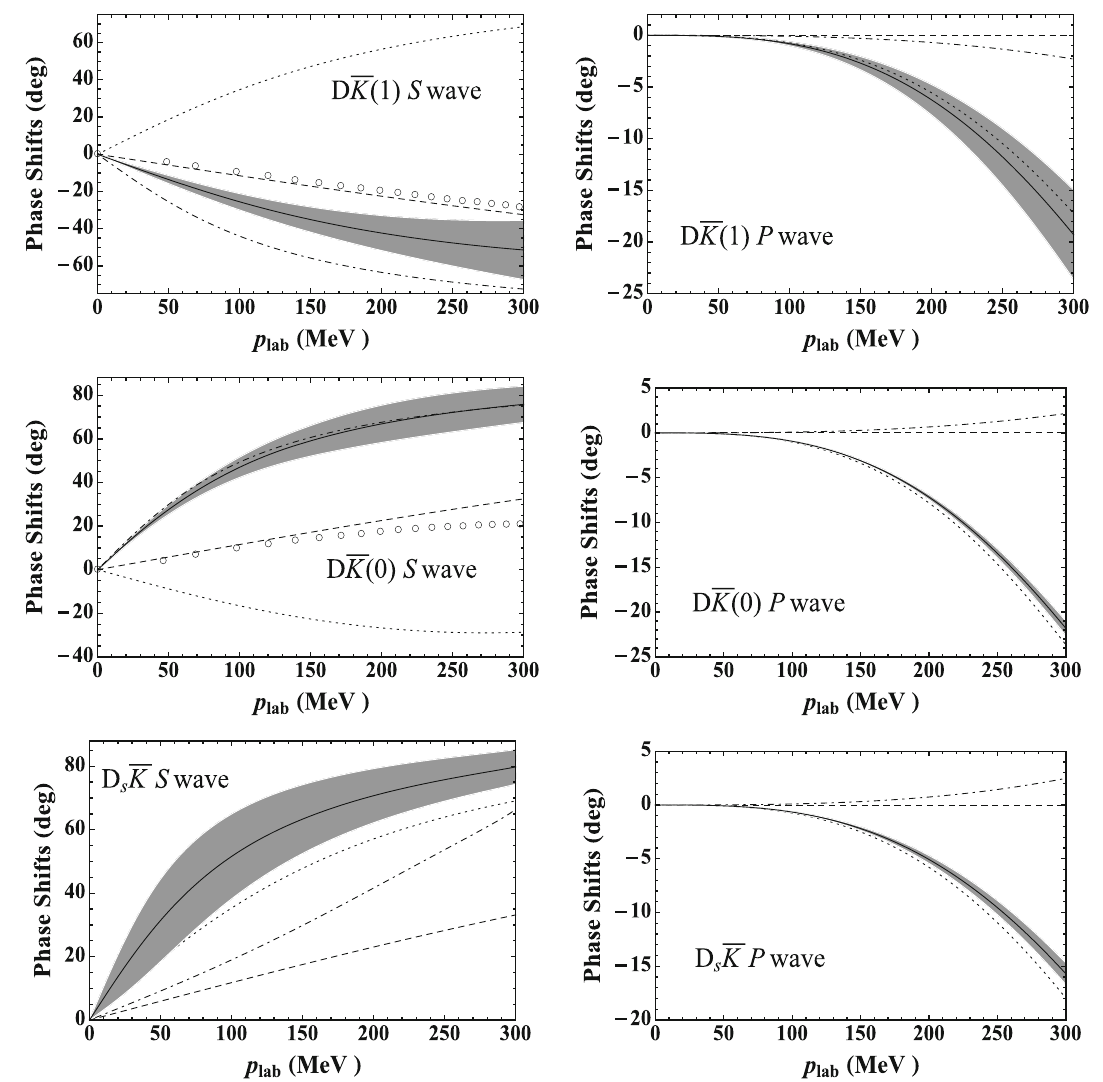
Fig. 5 Predictions for the antikaon- D meson phase shifts versus the antikaon laboratory momentum at physical meson values. The notation is the same as in Fig.